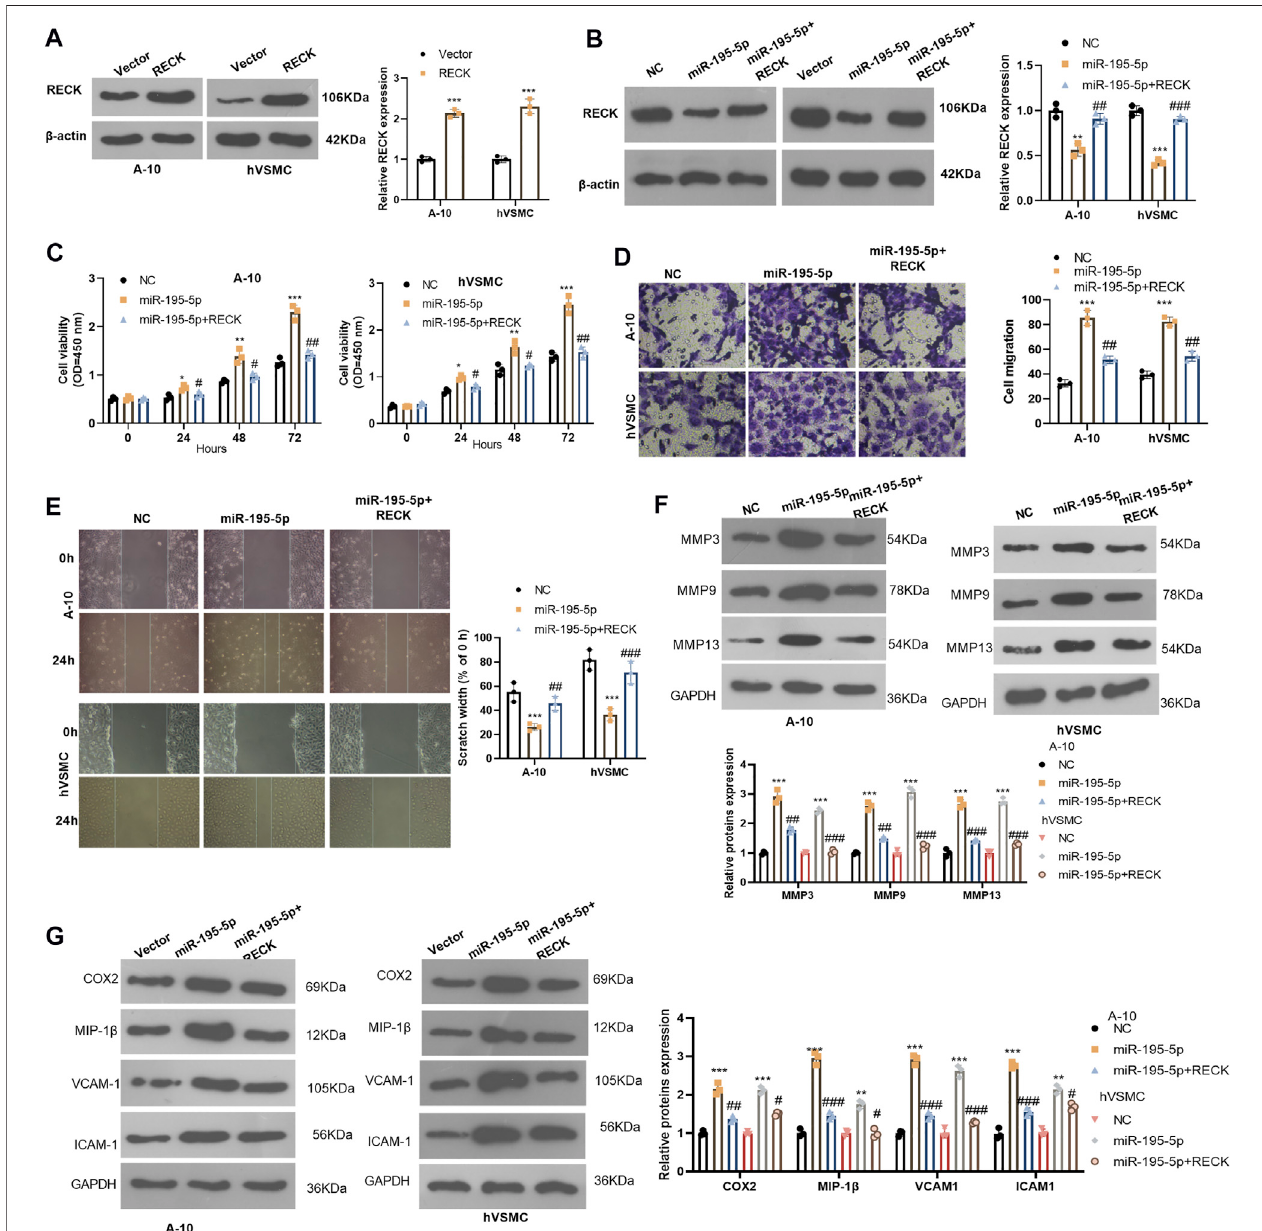
FIGURE 6 | Overexpressing RECK alleviated miR-195-5p-induced abnormal proliferation and migration of VSMCs. (A) A-10 cells and hVSMCs were transfected with vectors or RECK overexpression plasmids. The protein level of RECK was gauged by Western blot. (B) A-10 cells and hVSMCs were transfected with miR-195-5p mimics and/or RECK overexpression plasmids and then treated with hypoxia. (B) Western blot was applied to determine the RECK expression. (C) CCK-8 was applied to observe cell proliferation. (D,E) Transwell and wound healing assays were performed for evaluating cell migration; (F,G) The pro fi les of MMP3, MMP9, MMP13, COX2, MIP-1 β , VCAM-1 and ICAM-1 were analyzed by Western blot. * p < 0.05, ** p < 0.01, *** p < 0.001 (vs.Vector group); NS P > 0.05, # p < 0.05, ## p < 0.01 (vs.miR- 195-5p group). All experiments were repeated three times, and each time was performed in